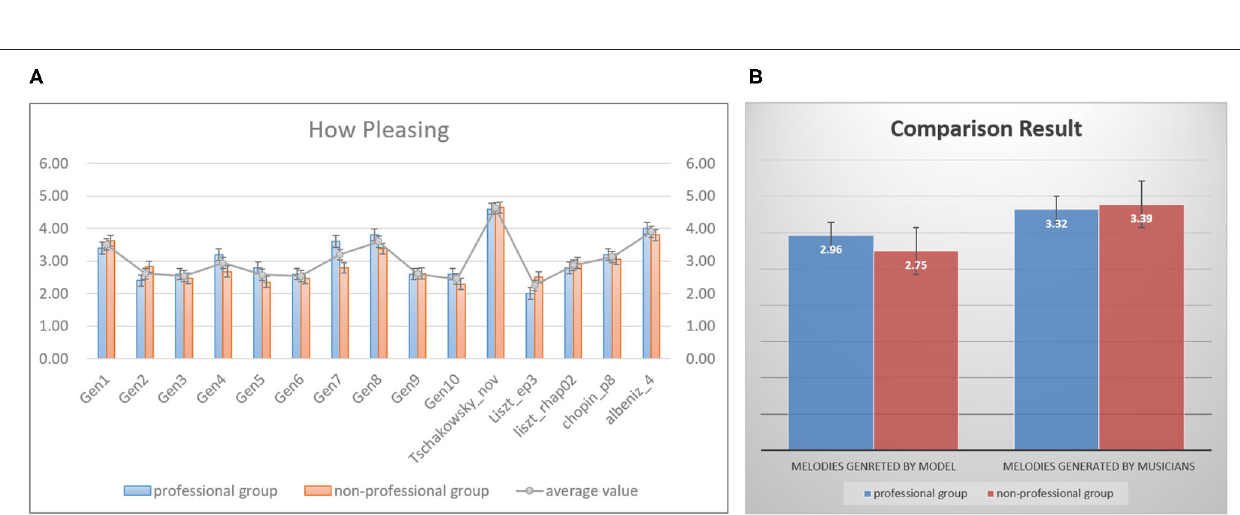
FIGURE 13 | The statistical results of a user study, for people (blue bars) with musical backgrounds and (orange bars) without musical backgrounds, (A) shows the average value of each melody in the testset, panel (B) exhibits that the total mean value of melodies generated by the model and